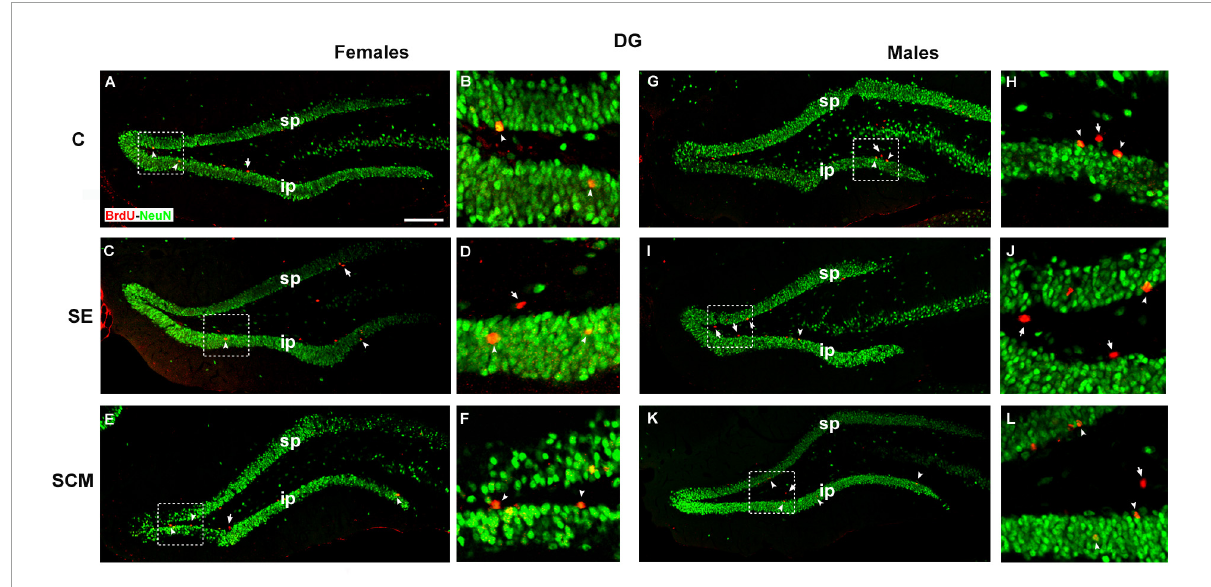
FIGURE7 Photomicrographs of double immunolabeling for BrdU (red; new cells) and NeuN (green; mature neurons) in the suprapyramidal (sp) and infrapyramidal (ip) blades (A,B) , control (C); (C,D) social exposure (SE) and (E,F) social cohabitation with mating (SCM) females. (G,H) C; (I,J) SE and (K,L) SCM males. Scattered square: enlargement of the inset at 20 × . White arrowheads: BrdU/NeuN-positive cells. White arrows: non-neuron BrdU-positive cells. 20 × . Scale bar: 100 µ